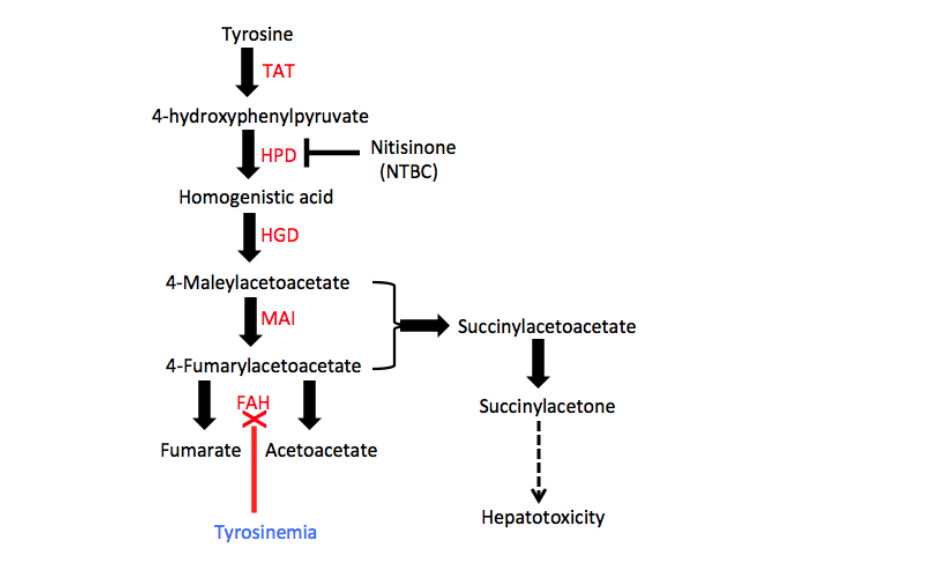
Figure 4. Use of the FAH model of HT to assess long-term hepatocyte proliferation. HT is caused by mutations in the FAH gene, which leads to accumulation of toxic tyrosine products, hepatocyte death and eventual liver failure [107]. Blocking the upstream enzyme HPD with Nitisinone (NTBC) prevents the formation of these catabolites and preserves hepatocyte viability and function. The disease process can also be reversed by transplanting donor Fah+/+ hepatocytes via intrasplenic administration. Over 3–4 months, during which time Nitisinone is periodically discontinued and then resumed, recipient hepatocytes succumb to their accumulated toxic tyrosine by-products and are replaced by migrant donor hepatocytes. After a 50–100-fold expansion, donor cells typically replace as much as 70–80% of the recipient’s liver and allow for Nitisinone-free survival. The model also permits the delivery of two or more populations of competing donor hepatocytes whose ability to repopulate the recipient liver can be directly compared within the same animal. Abbrevia-